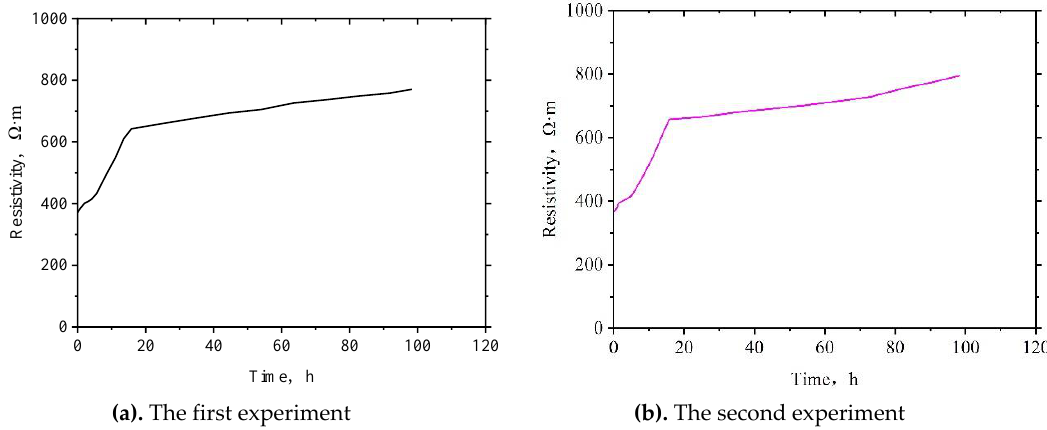
Figure 6. Resistivity changes during preparation of hydrate by stirring method.